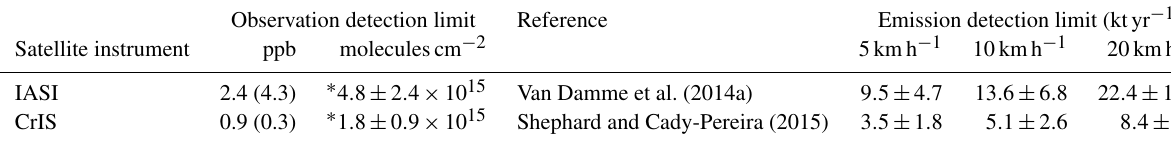
Table 2. Estimated emission detection limit.